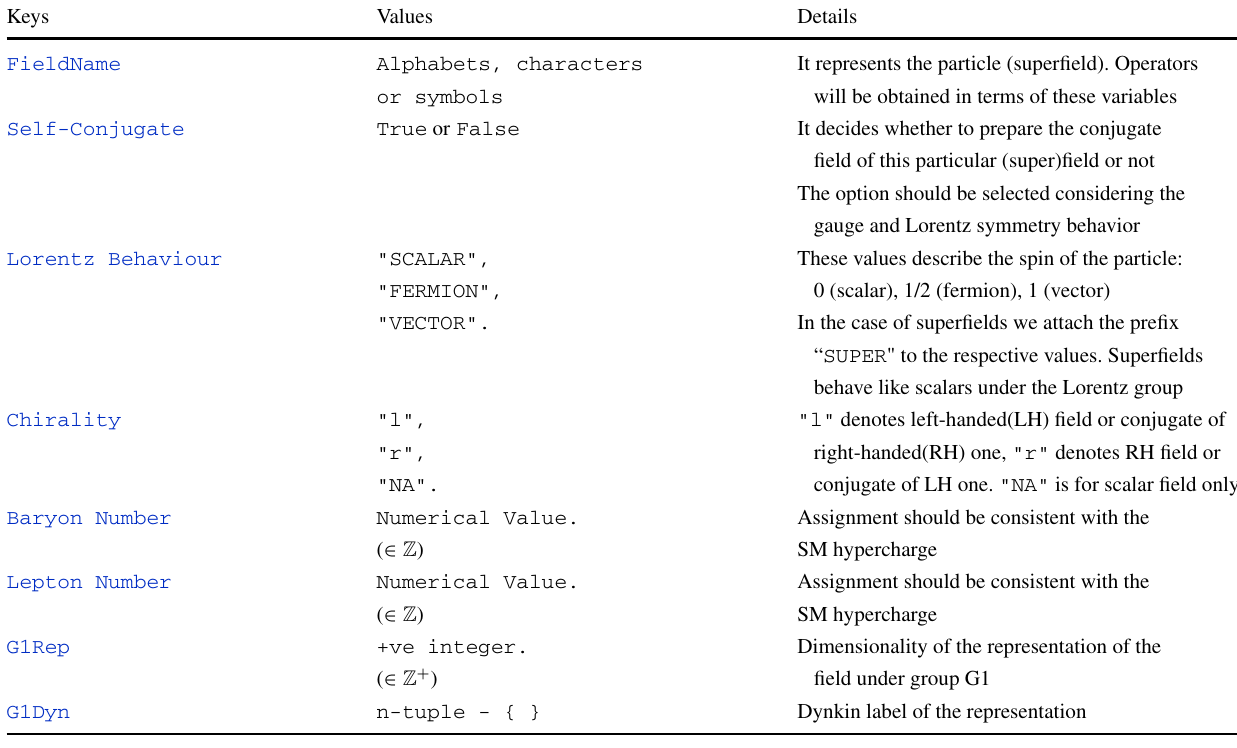
Table 11 Characteristics of the particles that must be specified within "(Super)FieldClass" and "(Super)FieldTensorClass" in the input file along with the possible